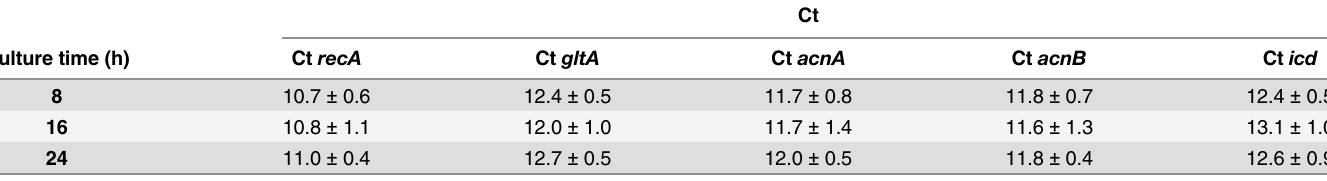
Table 4. Critical threshold (Ct) values for the genes recA , gltA , ancA , acnB and icd for three distinct times in B . pertussis Tohama I batch cultures.